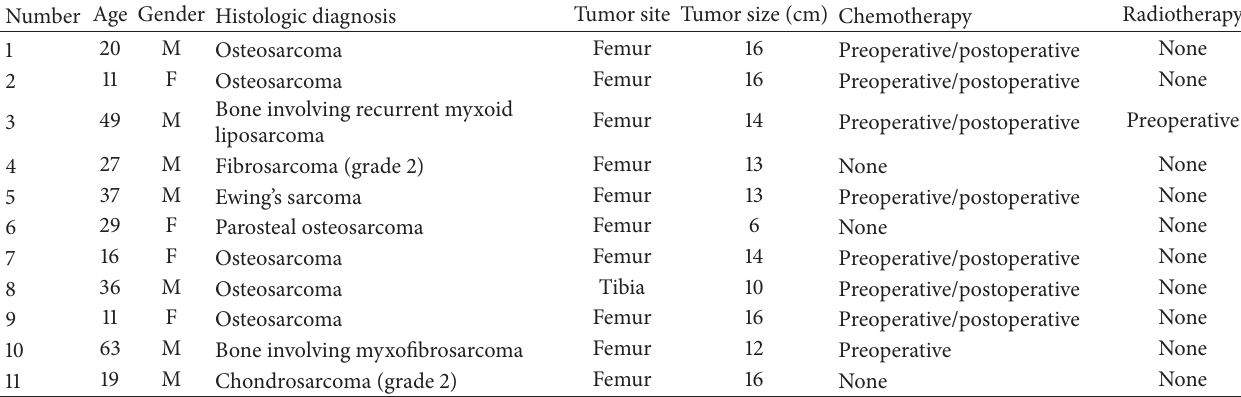
Table 1: Patient demographics and adjuvant therapy data.